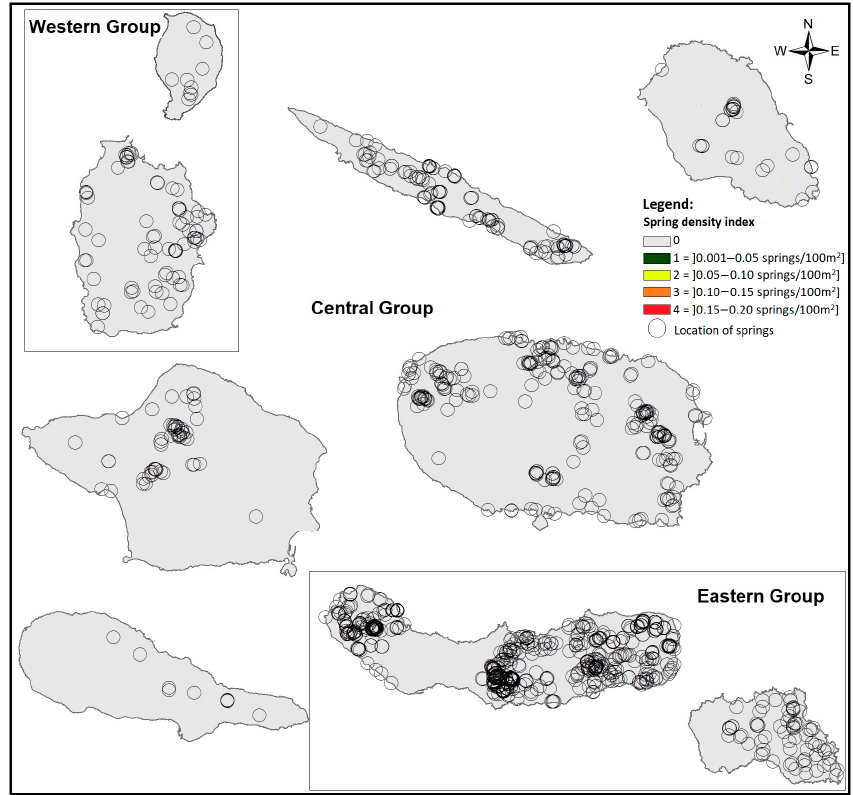
Figure 2. Mapping of the variables that compose the ecosystem dependence index: spring density. Considering the baseflow variable spatial representativeness, the class with the highest values was only observed in S ã o Miguel and Flores, with fractions of the total area of the islands equal to 5.75% (42.72 km 2 ) and 3.16% (4.46 km 2 ), respectively. Class 3 is also observed in Flores (5.46%; 7.70 km 2 ), Santa Maria (2.89%; 2.80 km 2 ), and S ã o Miguel